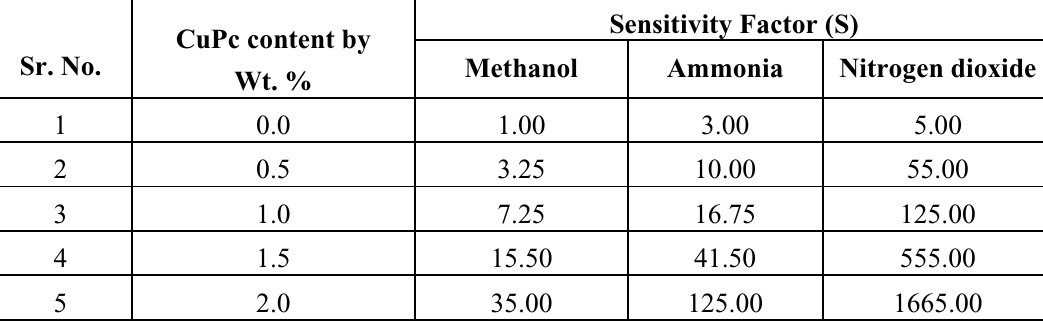
Table 2. Sensitivity of PPy-CuPc polymers with chemical vapours.